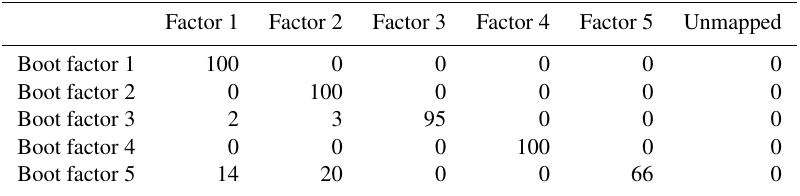
Table A2. Mapping of bootstrap factors to base factors.